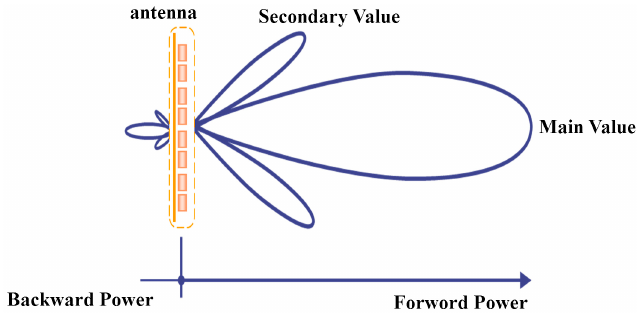
Figure 19. Schematic diagram of electromagnetic wave emission principle.